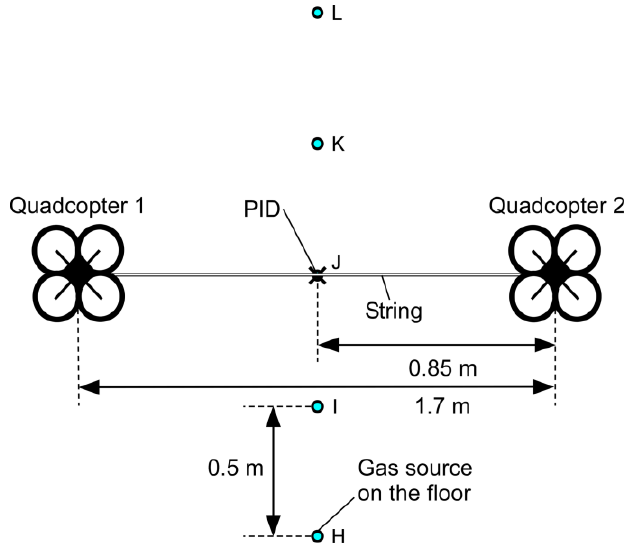
Figure 9. Top view of the experimental setup to investigate the range of gas detection in the direction perpendicular to the two quadcopters. The position of the gas source was moved from point H through points I–K to point L.